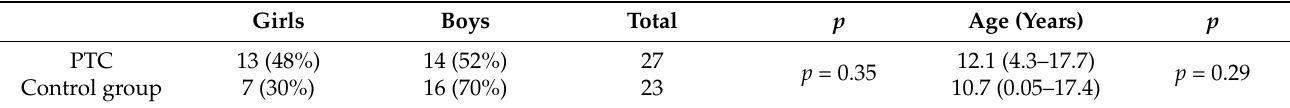
Table 1. Characteristics of the PTC and control